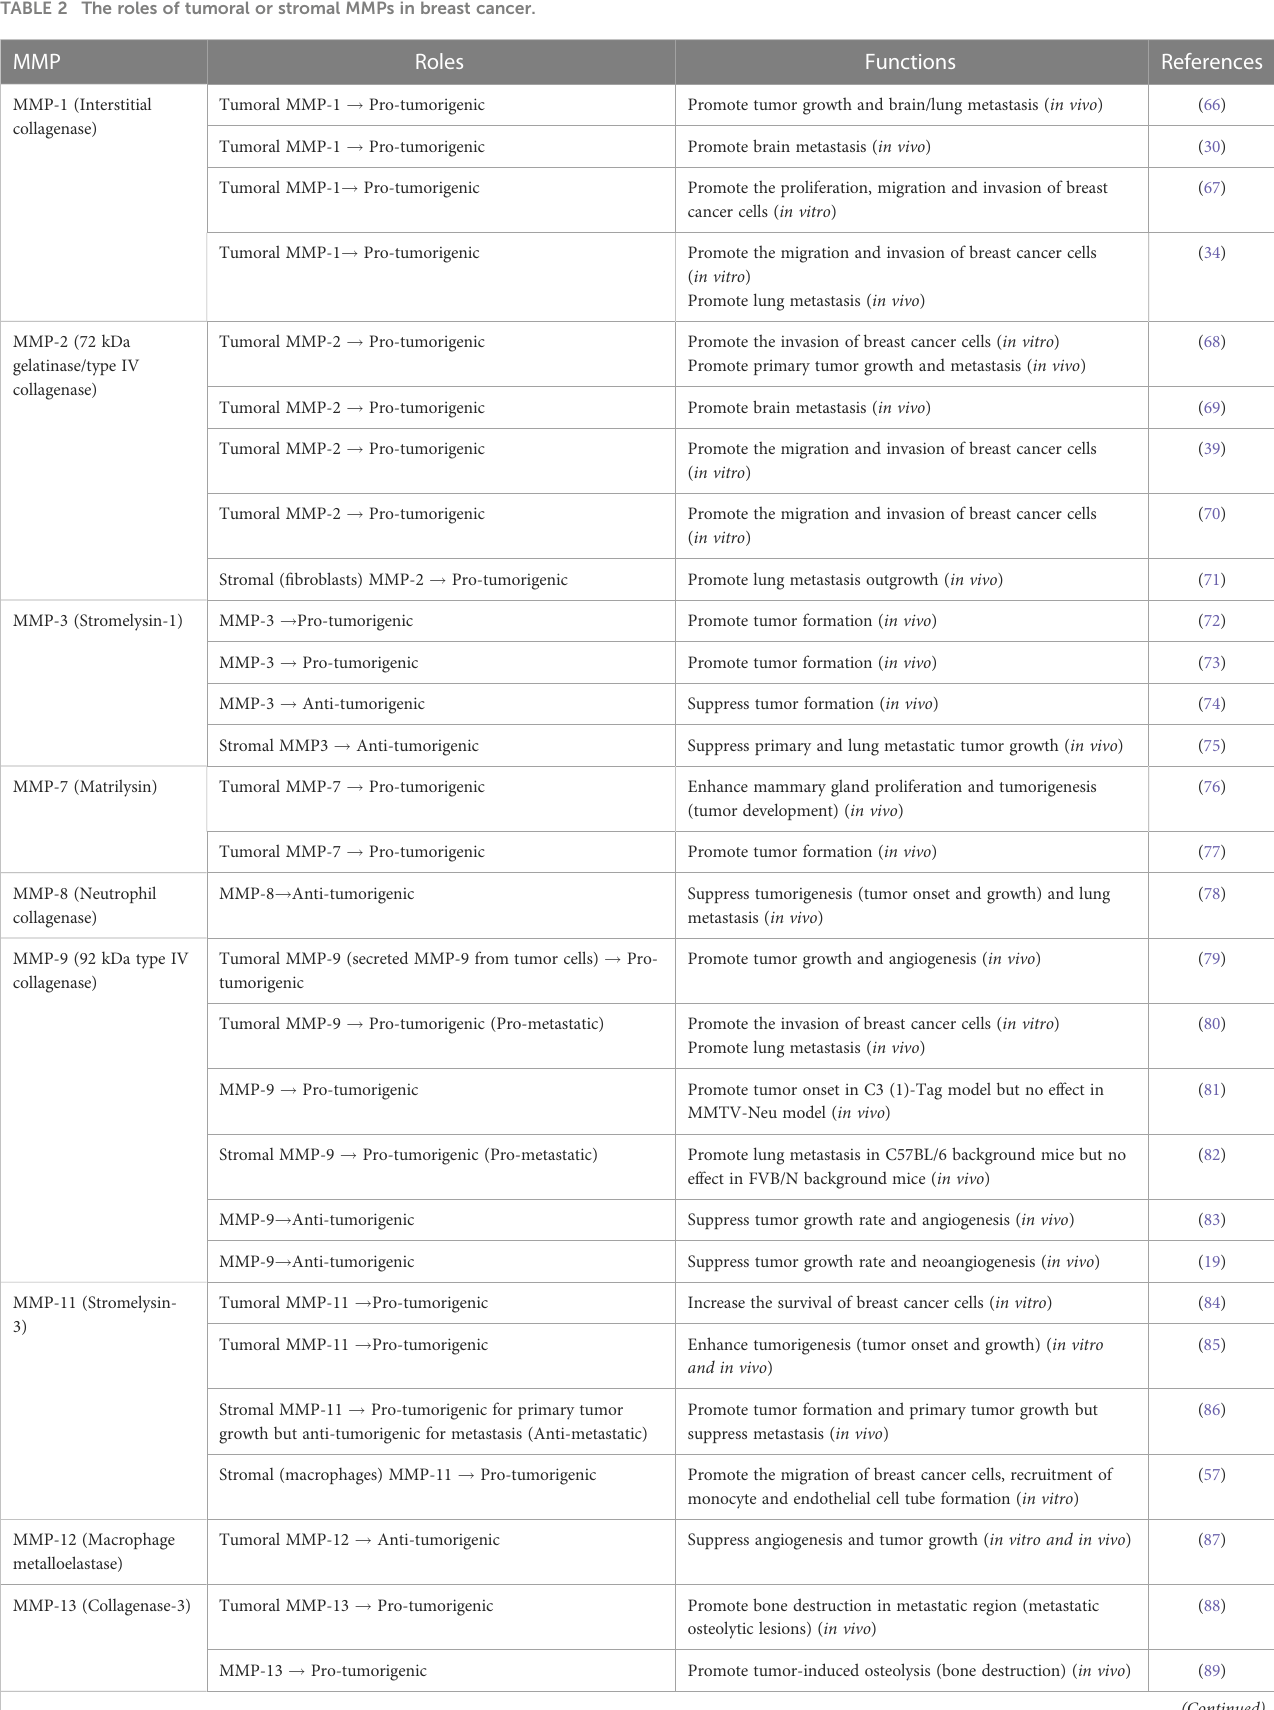
TABLE 2 The roles of tumoral or stromal MMPs in breast